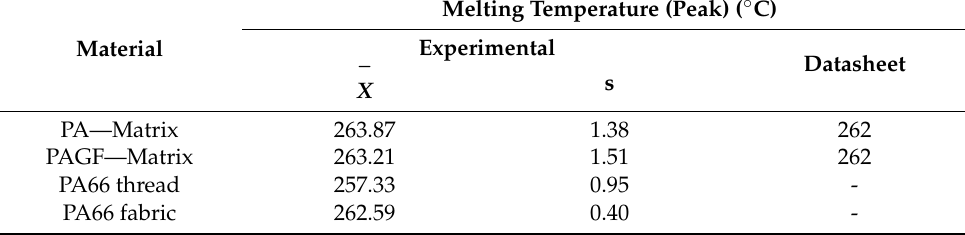
Table 8. DSC test results.